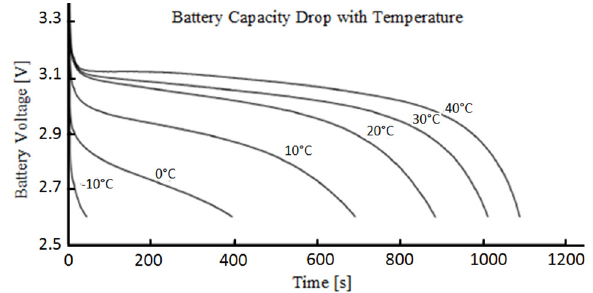
Figure 1. Experimental results indicating Li-ion battery discharge curves at various temperatures for a 3C discharge rate